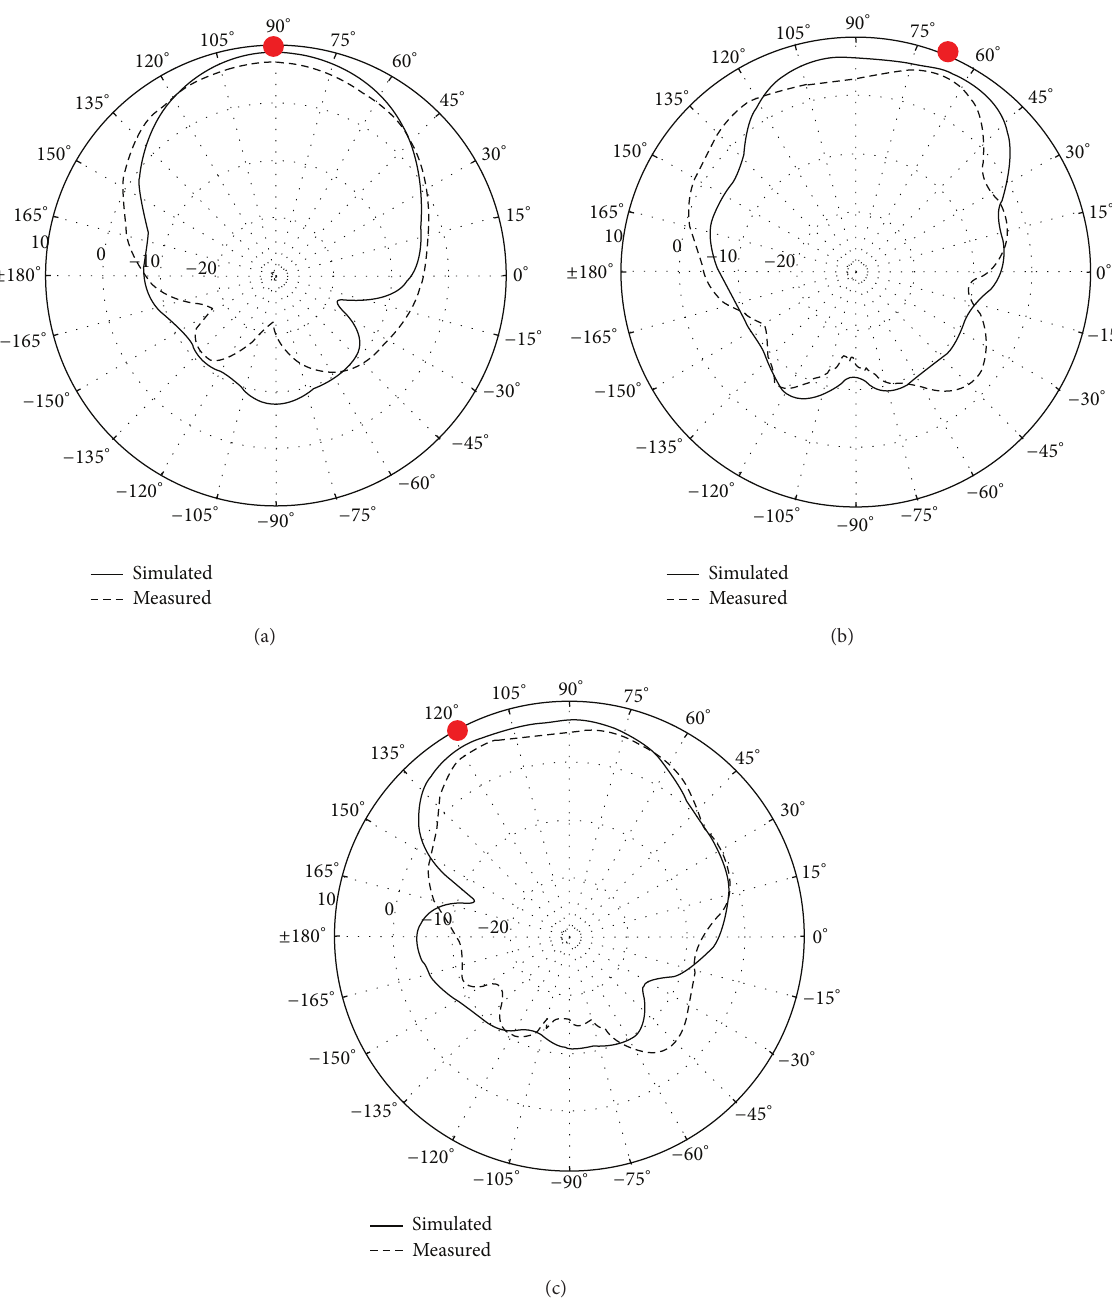
Figure 10: Comparison of measured and simulated 2D radiation patterns: (a) 𝜃 = 90 ∘ for 𝐻 01 = 𝐻 02 = 0 , (b) 𝜃 = 64 ∘ for 𝐻 01 = 0 and = 0.19 T, and (c) 𝜃 = 118 ∘ for 𝐻 𝐻 02